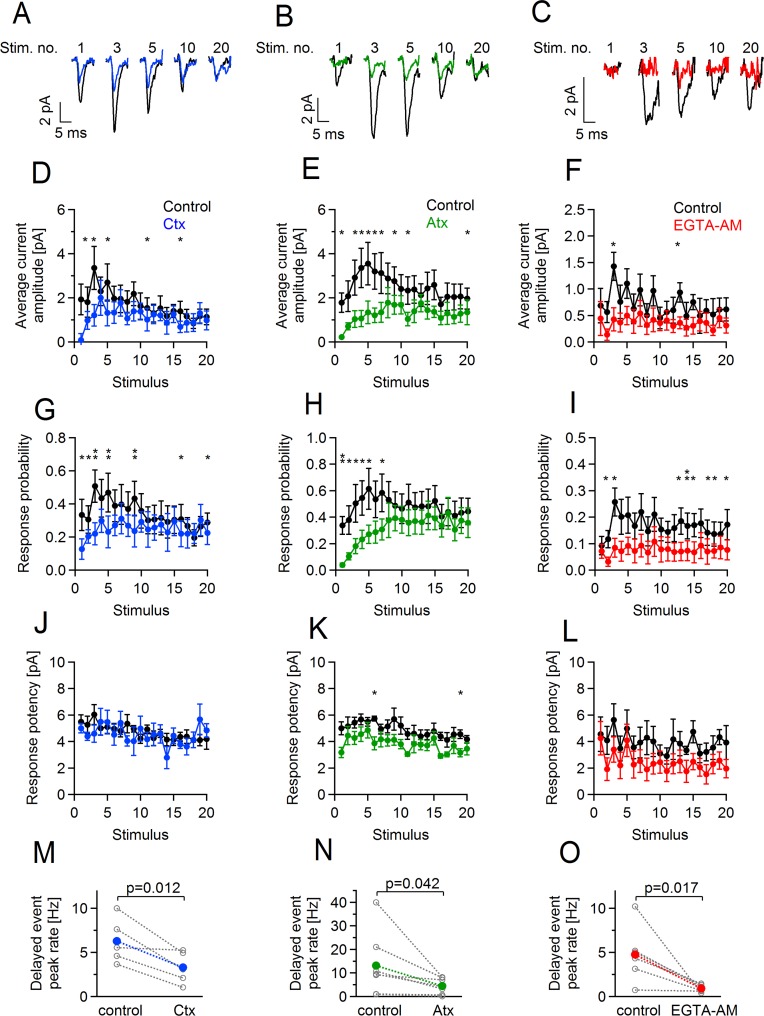
Reducing presynaptic Ca2+ level impairs short-term facilitation and delayed glutamate release at axon–oligodendrocyte precursor cell (OPC) synapses.(A–C) Example traces showing average currents (including failures) in three OPCs in response to the 1st, 3rd, 5th, 10th, and 20th stimuli in the train: under control conditions (before drug application, black), after 15 min perfusion of (A) ω-Conotoxin-GVIA (Ctx, 1 μM), (B) ω-Agatoxin-IVA (Atx, 0.5 μM), (C) after 10 min perfusion of ethylene glycol tetraacetic acid acetoxymethyl ester (EGTA-AM) (20 μM) via the bath. (D–L) Average current amplitude including failures, response probability, and response potency upon each stimulus of the train during control conditions and after perfusion of Ctx (n = 5 cells), Atx (n = 5 cells), and EGTA-AM (n = 6 cells). Each point represents mean ± SEM. Paired t test. (S2 Table, S3 Table and S4 Table). *p < 0.05, **0.001 < p < 0.01. (M–O) Peak rate of delayed currents in OPCs during control conditions and after perfusion of (M) Ctx, (N) Atx, (O) EGTA-AM. Each grey point represents an average peak rate in an individual experiment. Each point in color represents the mean peak rate within the experimental group, i.e., control, Ctx, Atx, and EGTA-AM. Paired t test (S3 Data). Throughout the figure: concentration of a given drug is the same. The shown traces during drug application are taken from the time period when the drug effect on the amplitude of the evoked currents or rate of delayed currents was on the steady state. The numerical data used in D–O are included in S4 Data.